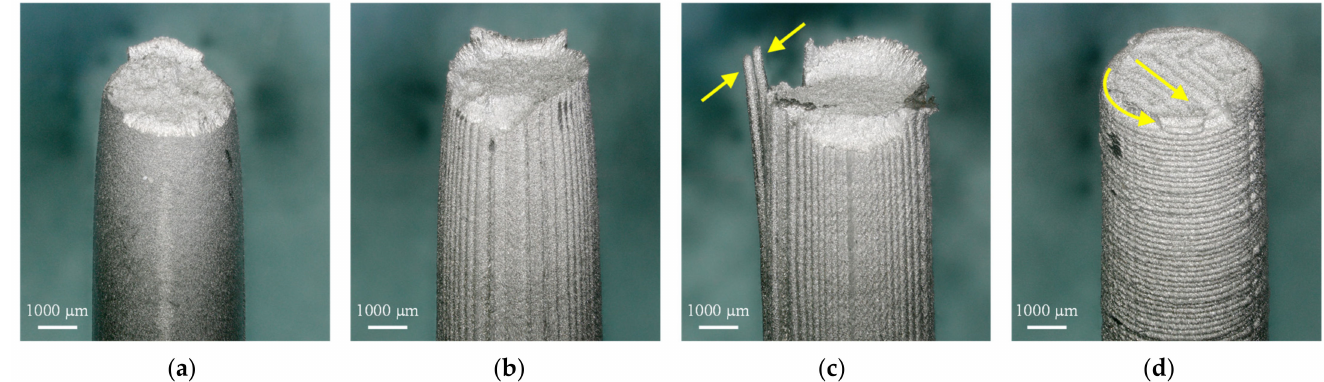
Figure 16. Fracture surfaces of tested tensile specimens ( a ) MIM reference; ( b ) flat orientation; ( c ) side orientation, yellow arrows show poorly connected extrusion paths in the area of the support structure; ( d ) vertical orientation, yellow arrows highlight visible extrusion paths in the fracture